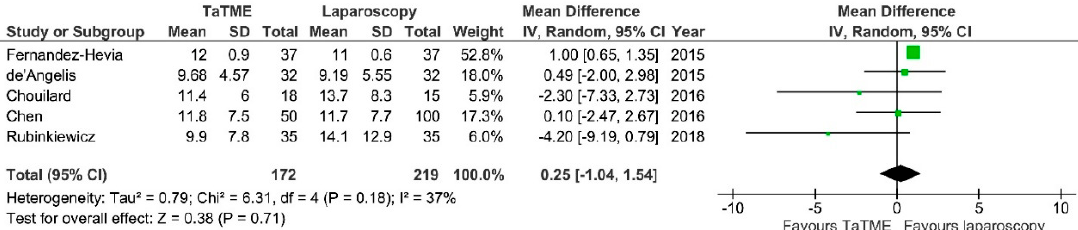
presented as diamond.